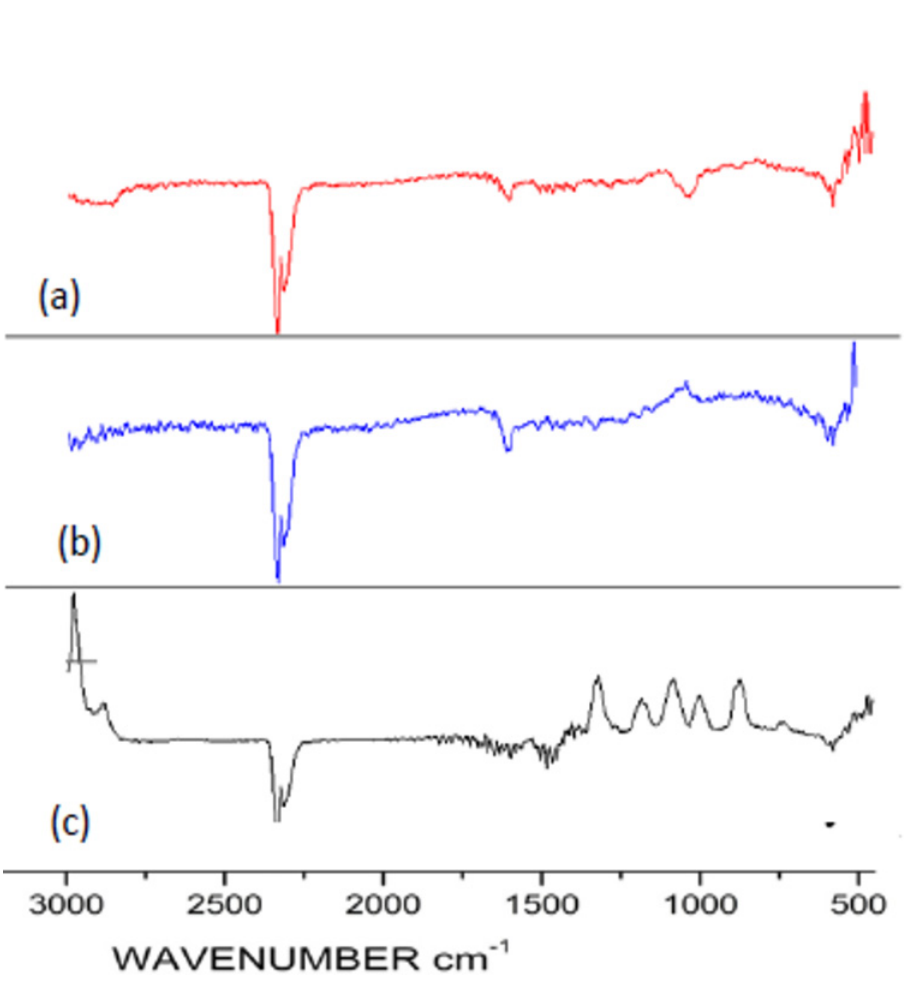
Fig 3. FTIR data for (a) the ZSM-5, (b) Fe-ZSM-5, and (c) Fe(byp) complex.